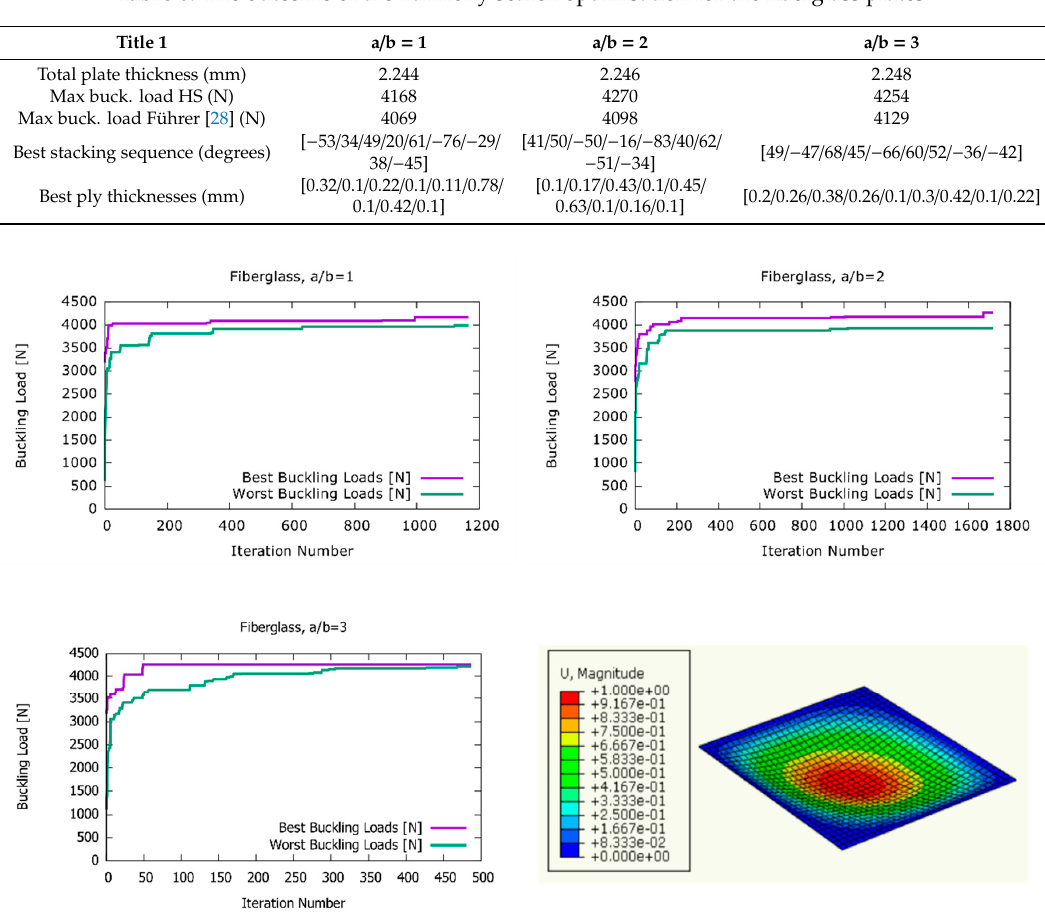
Table 6. The outcome of the harmony search optimisation for the fiberglass plates.